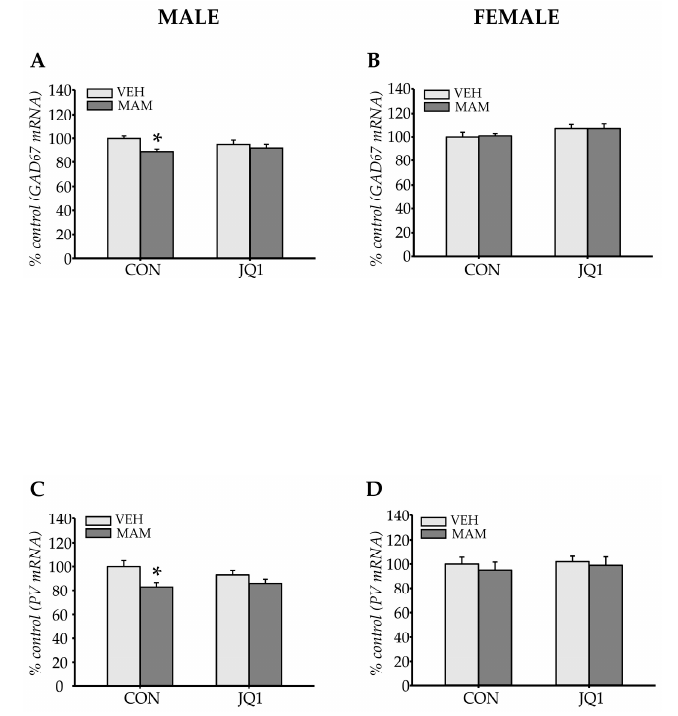
Figure 7. The effects of an adolescent JQ1 administration on GAD67 and parvalbumin (PV) gene expression in the adult medial prefrontal cortex in the MAM-E17 model of schizophrenia. The rats (males and females) were exposed to JQ1 or vehicle (CON) in early adolescence (P23–P29), and the analyses were performed in rats at P110. ( A , C ) GAD67 and PV expression in males, respectively. ( B , D ) GAD67 and PV expression in females, respectively. The data are expressed as percentage of VEH-CON. Each data point represents the mean ± SEM; n = 6 per group * p < 0.05 vs . VEH-CON (two-way ANOVA followed by a Tukey test).